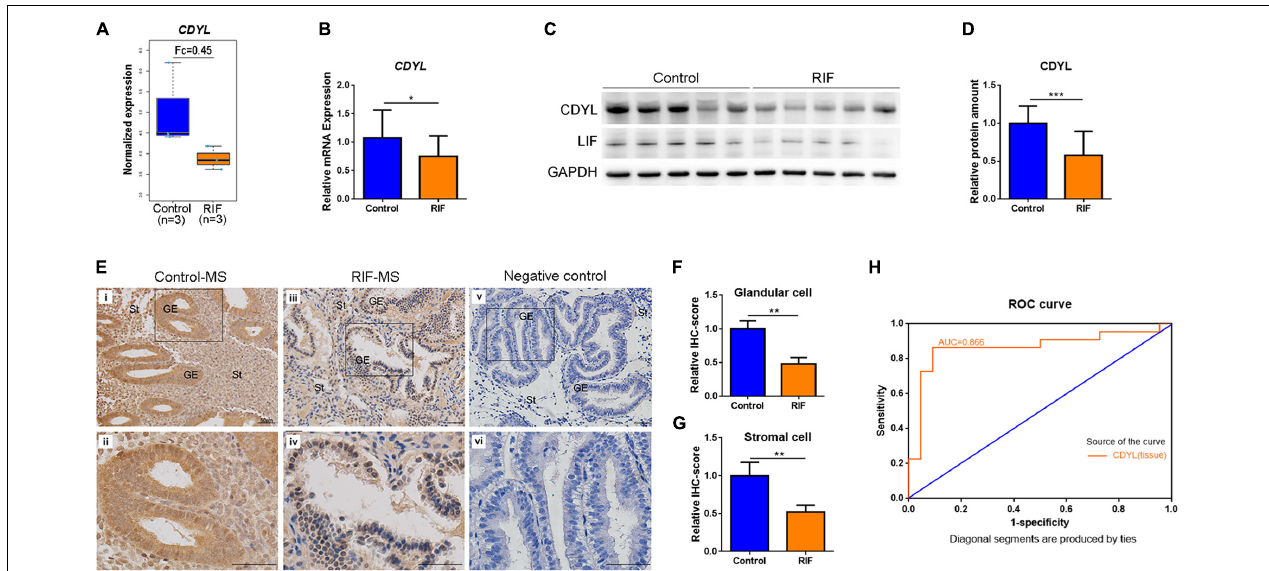
FIGURE 1 | The expression of CDYL was significantly decreased in the endometrium of women with RIF. (A) The expression levels of CDYL in the control ( n = 3) and RIF ( n = 3) groups using microarray assay. (B) The mRNA levels of CDYL in the endometrium of the control ( n = 22) and RIF ( n = 22) groups. (C) Representative western blot analysis of CDYL and LIF in the control and RIF groups. (D) Densitometric quantification of CDYL in the endometrium of the control ( n = 22) and RIF ( n = 22) groups. (E) Immunohistochemistry staining and (F,G) semi-quantification of CDYL protein expression in the control ( n = 5) and RIF patients ( n = 5). Bar = 50 µ m. (H) Receiver operating characteristic (ROC) curve plotting of the true positive vs. false positive rate, and the optimal cutoff value for endometrial issue for CDYL measurements. All data are presented as mean ± SD. * P < 0.05; ** P < 0.01; *** P < 0.001.